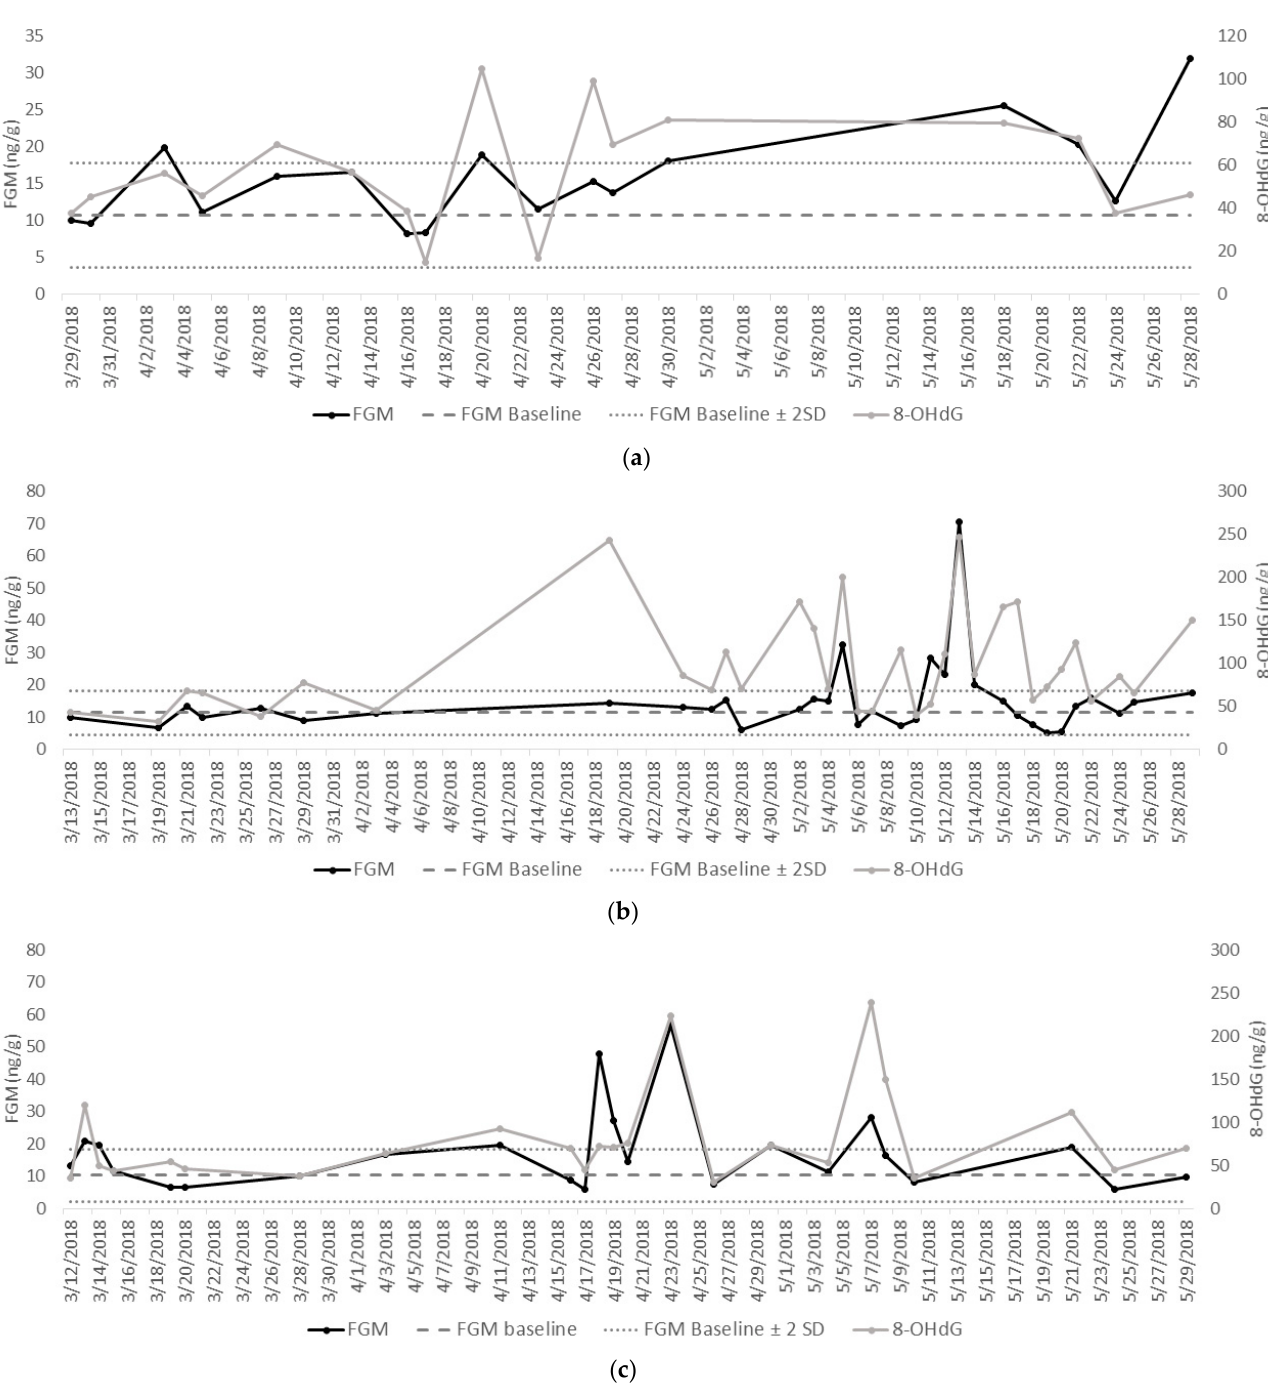
Figure 3. Scatterplots comparing log-transformed concentrations of fecal glucocorticoid metabolites (FGM) and fecal oxidized guanine (8-OHdG) in three male grizzly bears while they occupied a temporary, smaller habitat. Concentrations are expressed as ng/g dry feces.